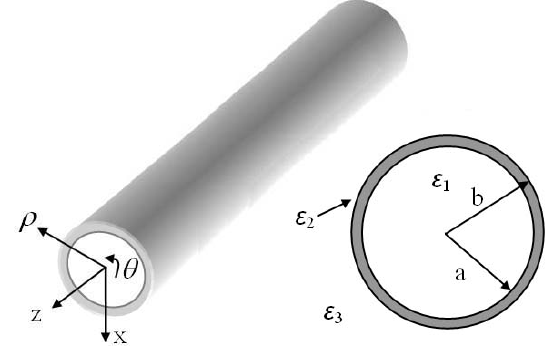
Figure 1. (a) Schematic of the cylindrical dielectric waveguide. (b) Cross section of the waveguide with inner radius b and outer radius a. Relative permittivity of each medium are labeled as ε , ε and ε 1 2 3